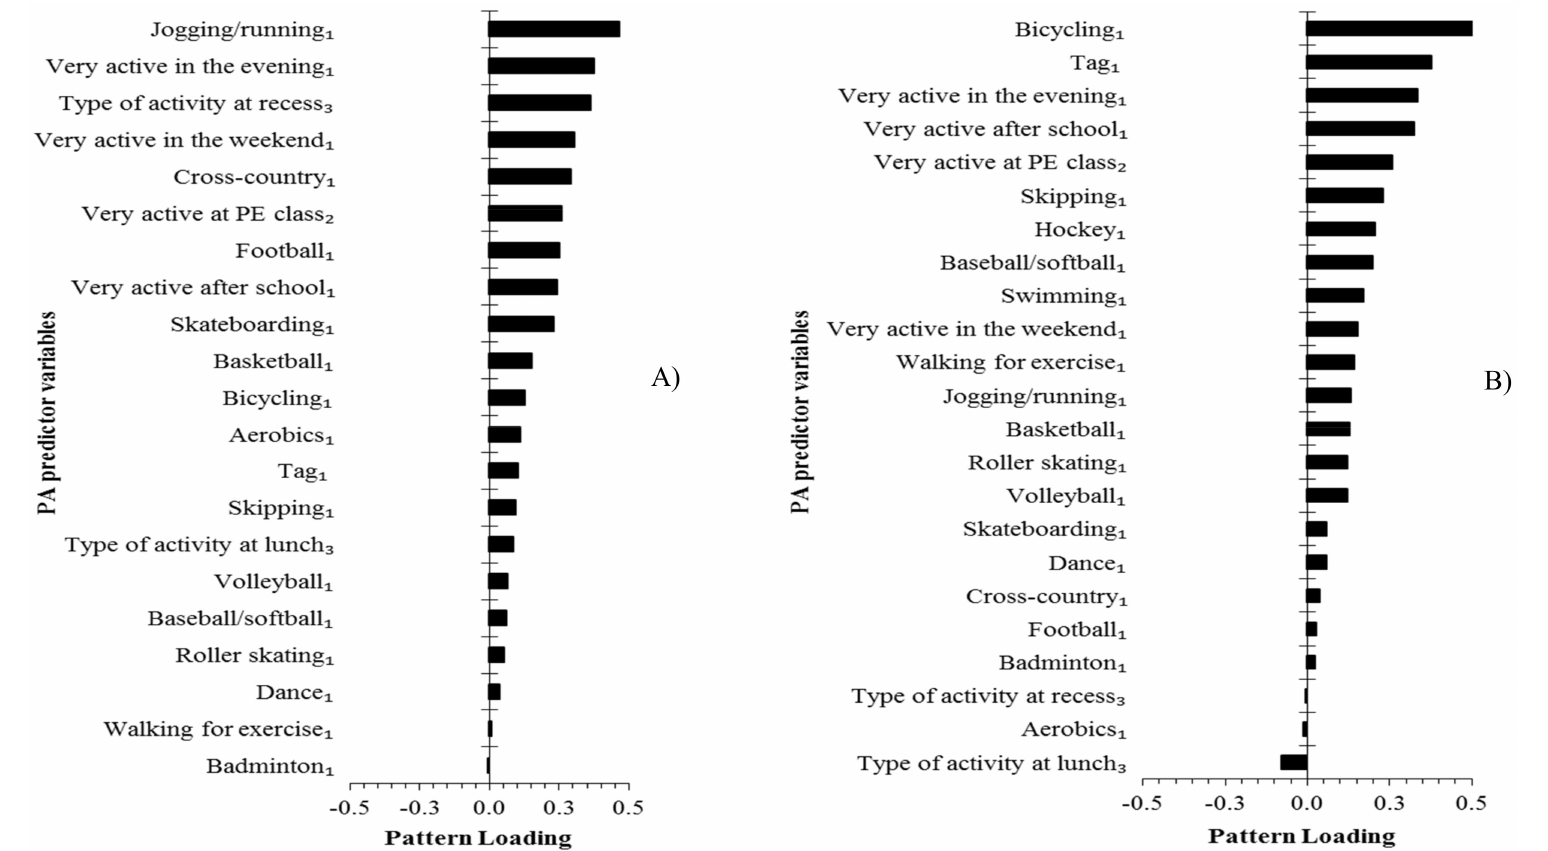
Figure 1. Physical activity (PA) pattern loadings for each predictor variable at age 13 years in ( A ) boys and ( B ) girls. 1 Measured in times per week. 2 Range 1 to 5—1: I don’t do PE, 2: Hardly ever, 3: Sometimes, 4: Quite often, and 5: Always. 3 Range 0 to 5—1: Sat down, 2: Stood / walked around, 3: Ran / played a little bit, 4: Ran / played quite a bit, and 5: Ran / played hard most of the